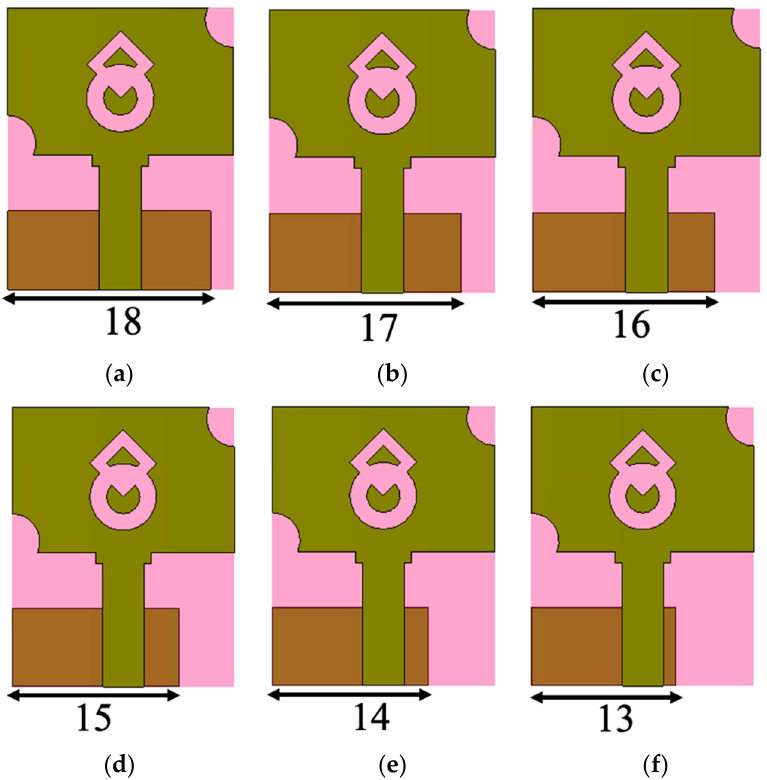
Figure 4. Parametric analysis of the antenna with varying ground plane width (GW). ( a ) GW = 18 mm, ( b ) GW = 17 mm, ( c ) GW = 16 mm, ( d ) GW = 15 mm, ( e ) 14 mm, ( f ) 13 mm.